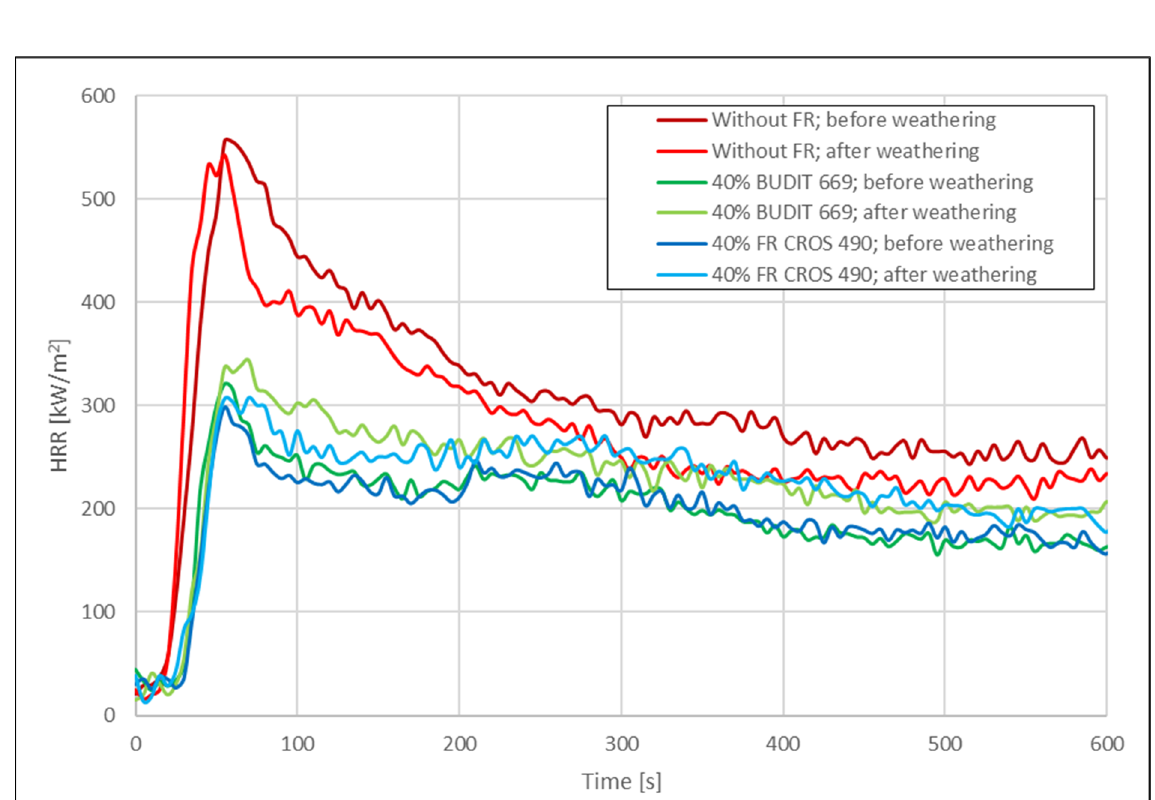
Figure 5. HRR of co-extruded hollow-core profiles before and after artificial weathering according to DIN EN ISO 4892-2 (cycle 2).